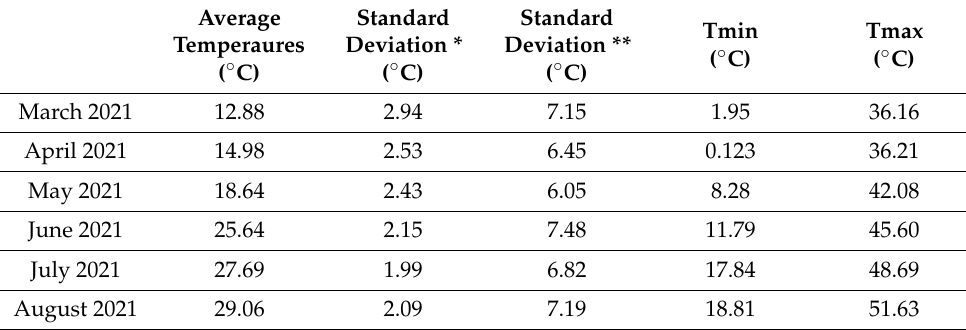
Table 3. Environmental parameters measured in a sandbox placed in